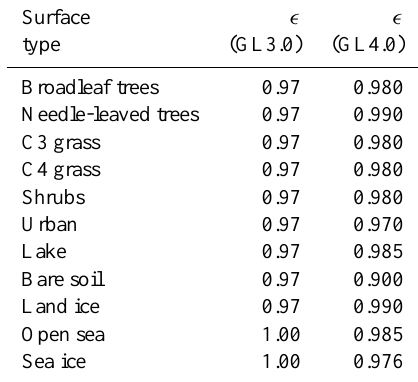
Table 4. Changes to the surface emissivity ( (cid:15) ) for each surface type between GL3.0 and